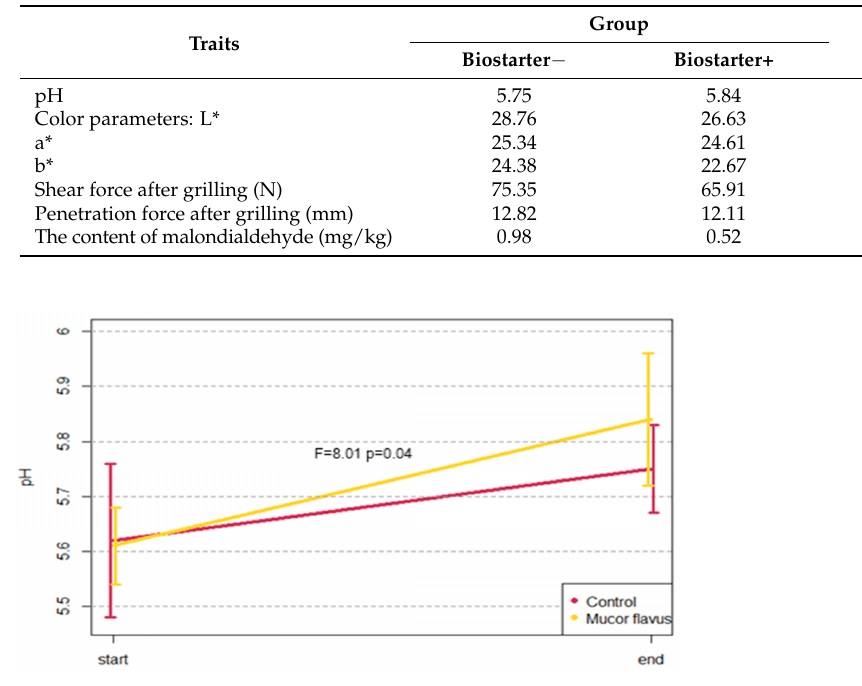
Figure 2. Changes of pH during aging. Average values with standard deviation bars are shown. Table 2. Characteristics of beef quality after dry-aging.